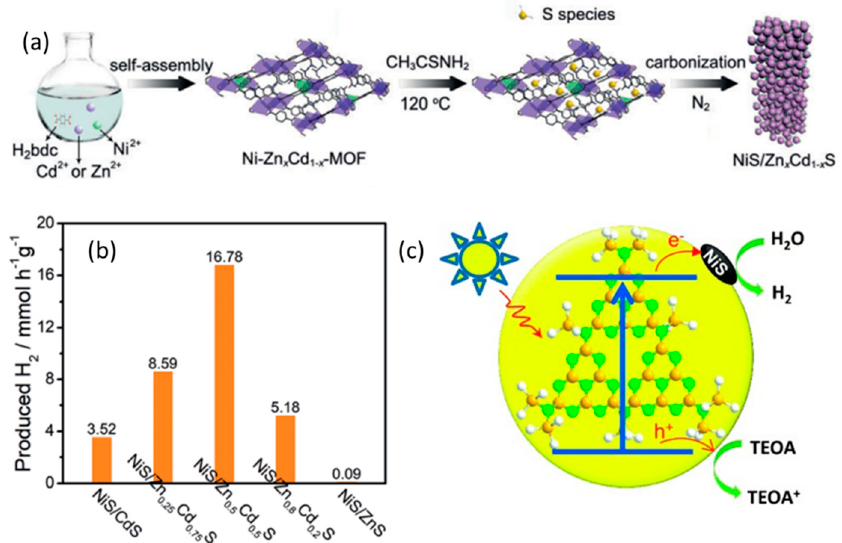
Figure 7. ( a ) Schematic illustration of the synthetic procedure for NiS / Zn x Cd 1 − x S; ( b ) comparison of H 2 -evolution rates of NiS / Zn x Cd 1 − x S under visible-light irradiation. Adapted with permission from [33]; ( c ) schematic illustration of photocatalytic hydrogen evolution of NiS / C 3 N 4 . Adapted with permission from [34].